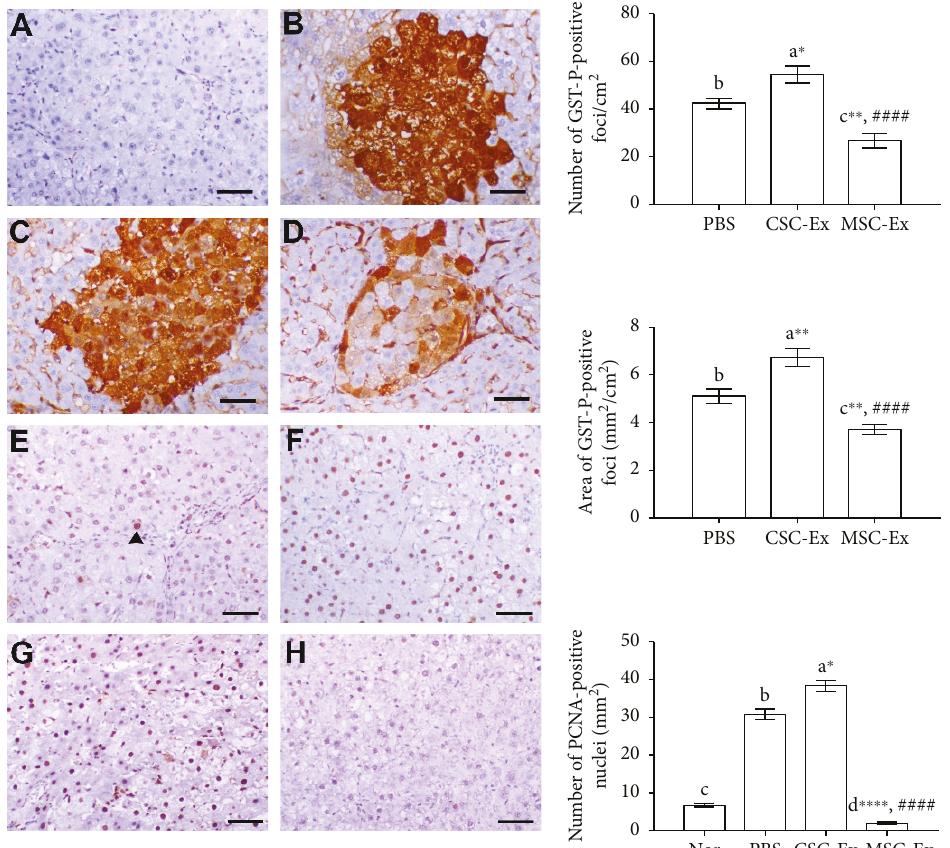
Figure 6: Immunostaining for GST-P (A – D) and PCNA (E – H) in livers of rats in the normal group (A, E), PBS group (B, F), CSC-Ex group (C, G), and MSC-Ex group (D, H). Arrowhead points to PCNA-positive nucleus. Scale bar: (A) E – H, 50 μ m, B – D, 30 μ m. The graphs show mean number and area of GST-P-positive foci and number of PCNA-positive nuclei in di ff erent rat groups. Data was presented as mean ± SEM ( n = 9 ). Di ff erent letters on columns mean signi fi cant di ff erence. ∗ P < 0 05 , ∗∗ P < 0 01 , and ∗∗∗∗ P < 0 0001 versus PBS group; #### P < 0 0001 versus CSC